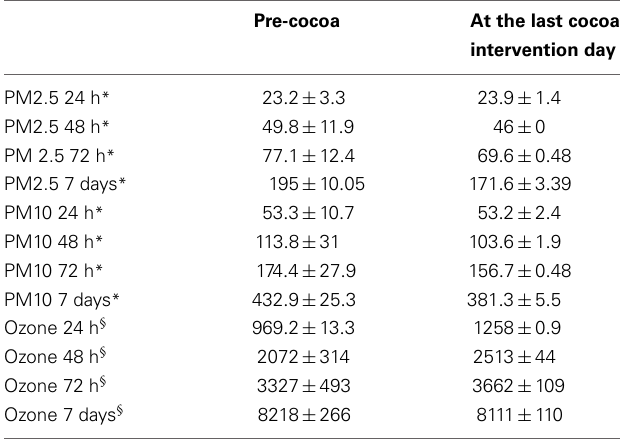
Table 1 | Cumulative air pollutant results in Mexico City children pre and post-cocoa.